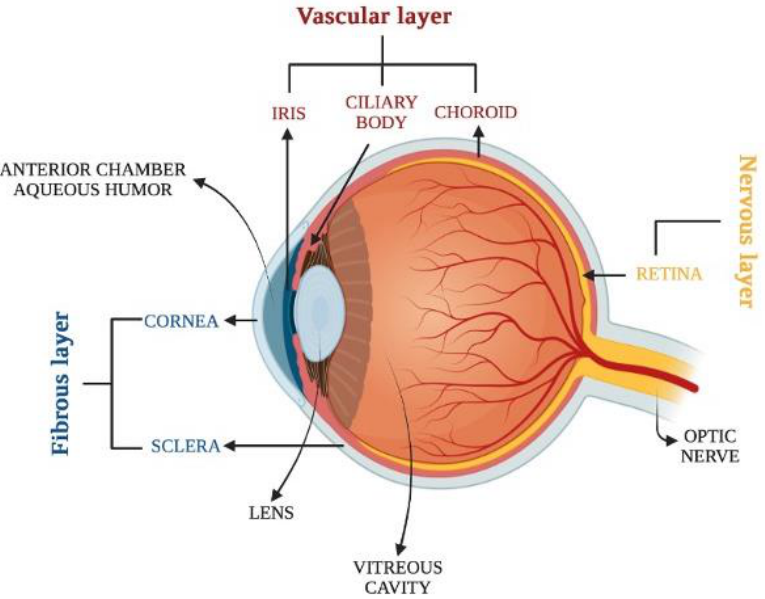
Figure 1. The basic anatomy of the human eye.